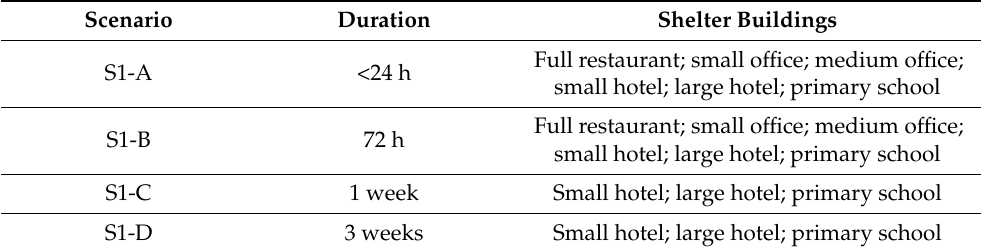
Table 2. Various energy outage